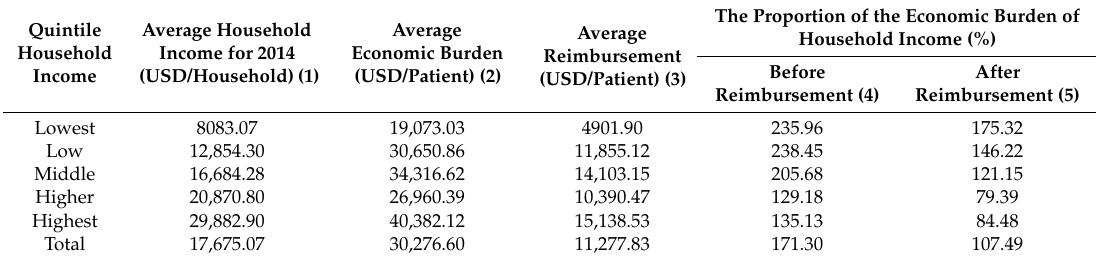
Influence of the financial burden in the first year after diagnosis on the family economic